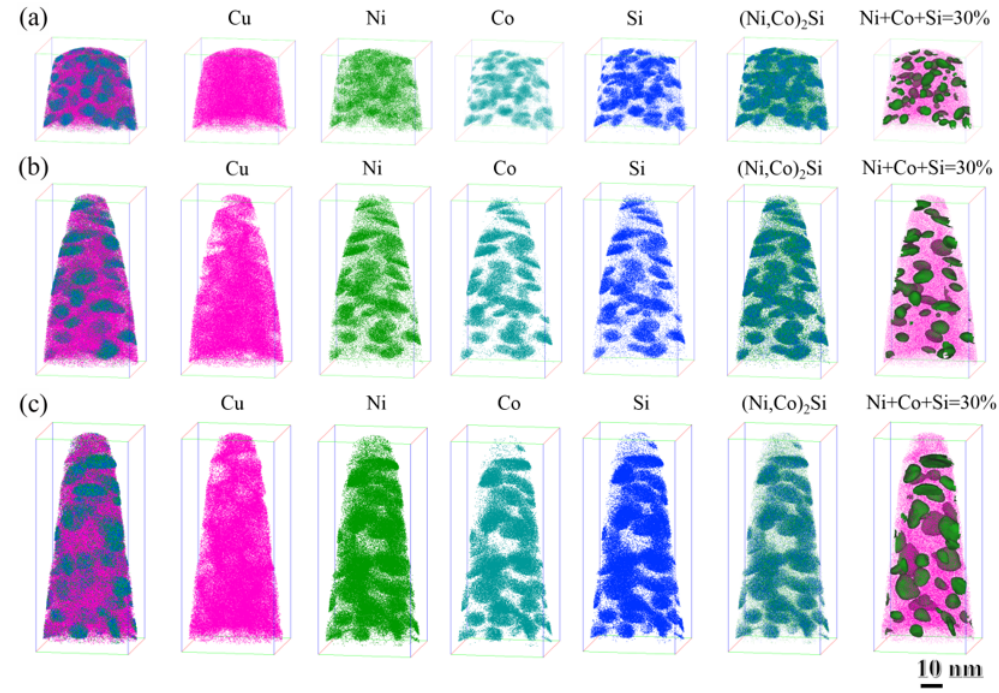
Figure 8. Three-dimensional atom probe (3DAP) elemental maps showing Cu, Ni, Co, and Si atoms and the corresponding map of precipitates in the studied alloys aged at 500 ◦ C for 1h; ( a ) NC-2, ( b ) NC-4, and ( c )